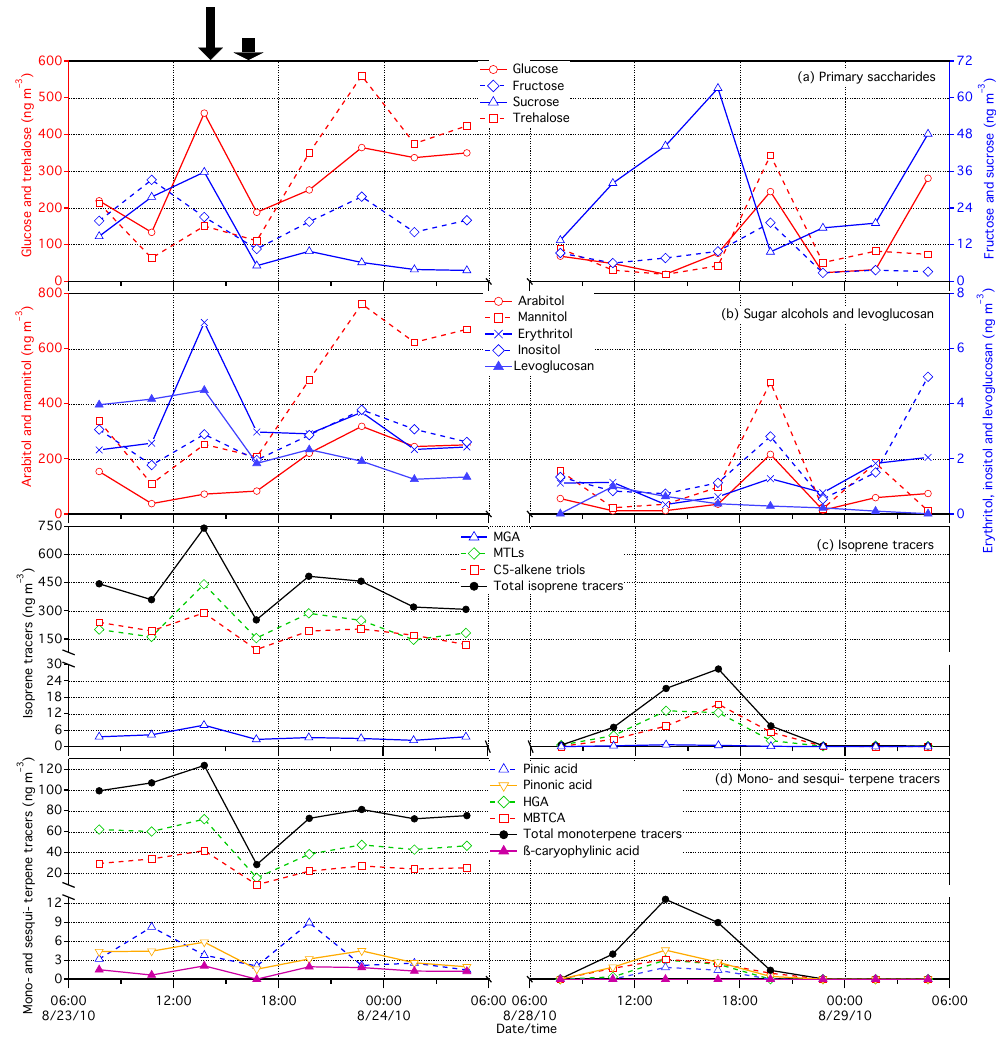
Figure 3. Diurnal profiles of organic compounds in forest aerosols in Wakayama on 23–24 August (left) and 28–29 August 2010